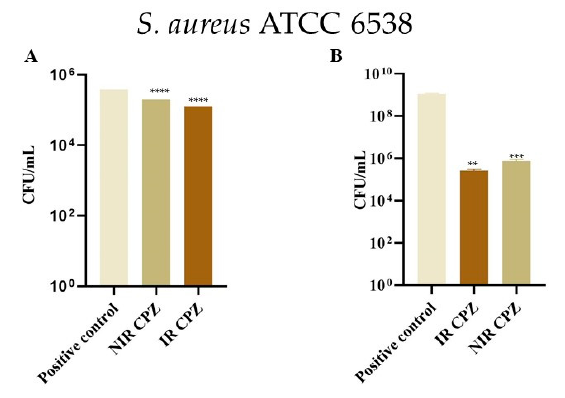
Figure 4. CFU / mL of S. aureus ATCC 6538 after 24 h on ( A ). cannula patch and ( B ). cotton treated before with non-irradiated and laser irradiated solutions. Legend: NIR-CPZ = non-irradiated CPZ and IR-CPZ = irradiated CPZ (data expressed as Mean ± SEM, data points analysed by t -test, levels of statistical significance between the analysed groups: **** p ≤ 0.0001, ** p ≤ 0.05, *** p ≤ 0.001). The positive control is represented by bacterial cultures alone.